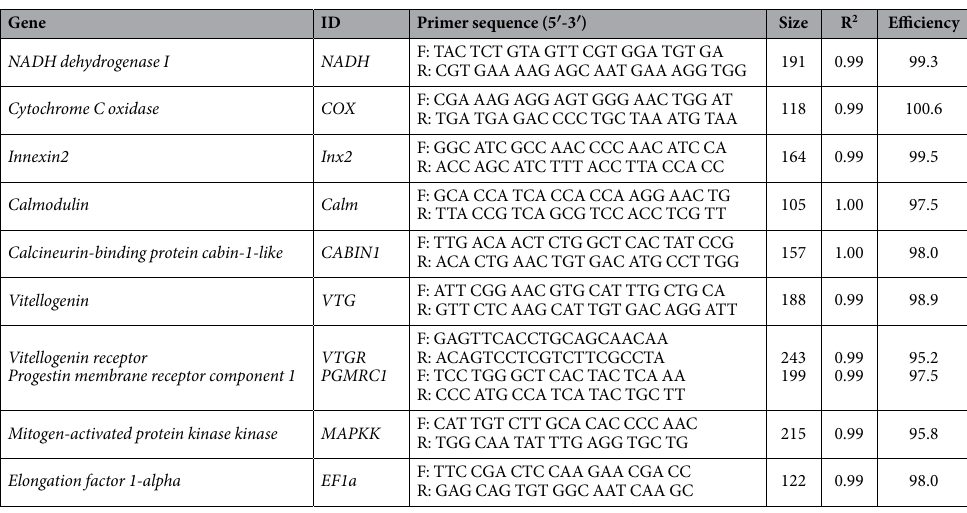
Table 2. Primers used in quantitative real-time PCR (qPCR)